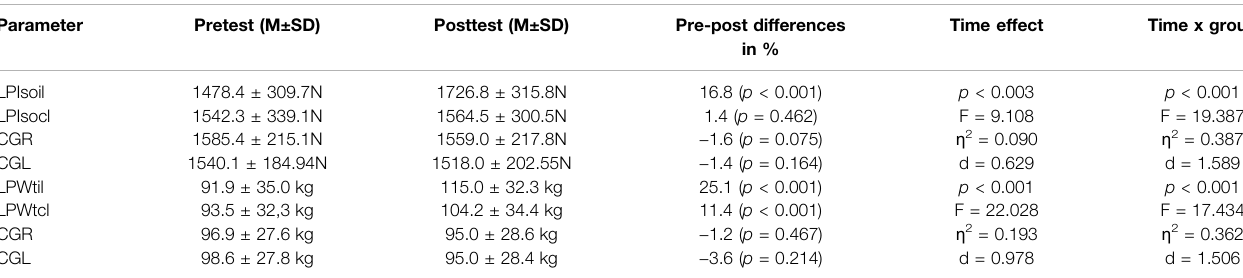
TABLE 3 | Descriptive statistics and two-way ANOVA of maximal strength